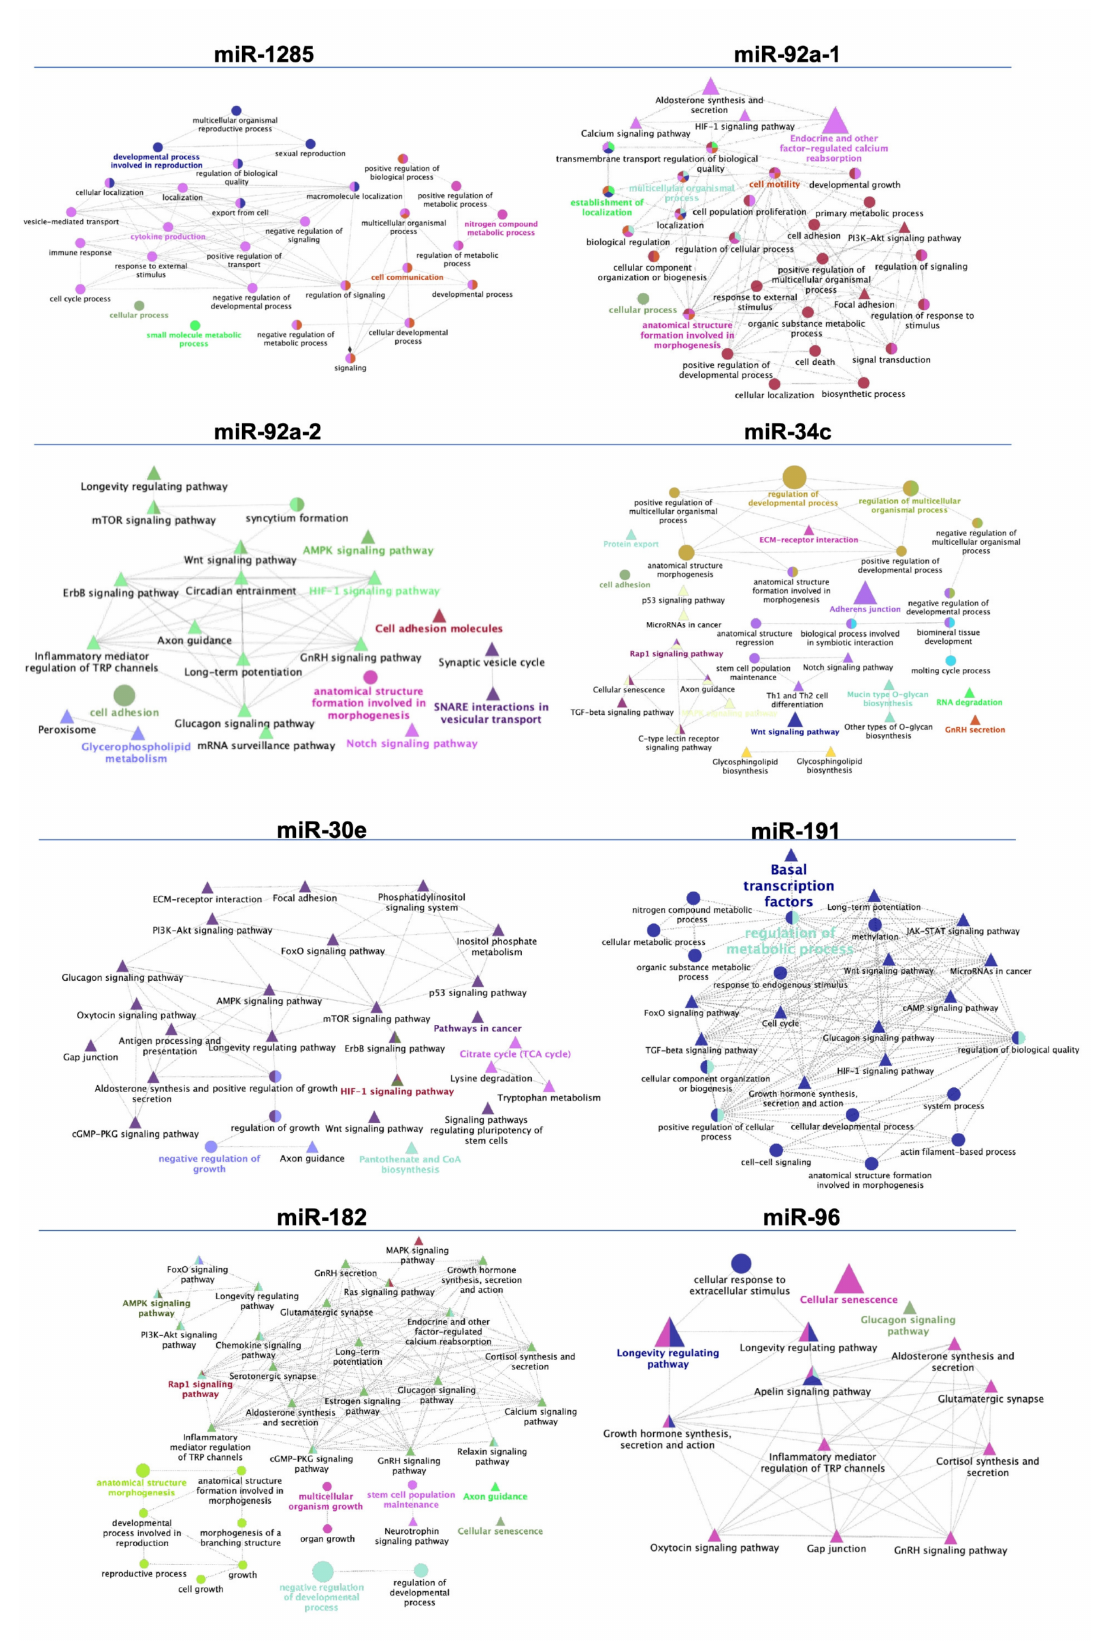
Figure 4. Schematic representation of biological processes and pathways (KEGG) associated